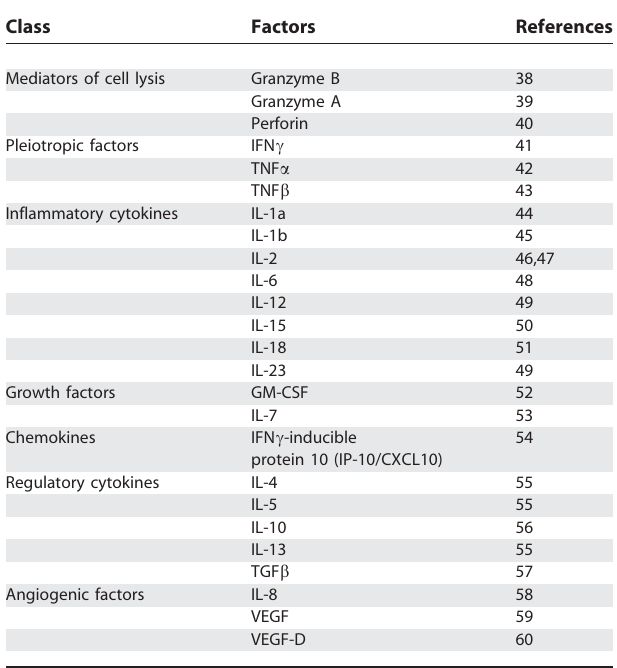
Table 1. Factors Secreted by Lymphocytes or Other Cells of the Immune